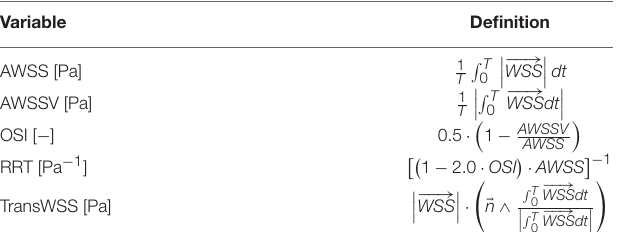
TABLE 2 | Definition of time-averaged WSS magnitude (AWSS), time-averaged WSS vector (AWSSV), Oscillatory Shear Index (OSI), Relative Residence Time (RRT), and Transversal WSS